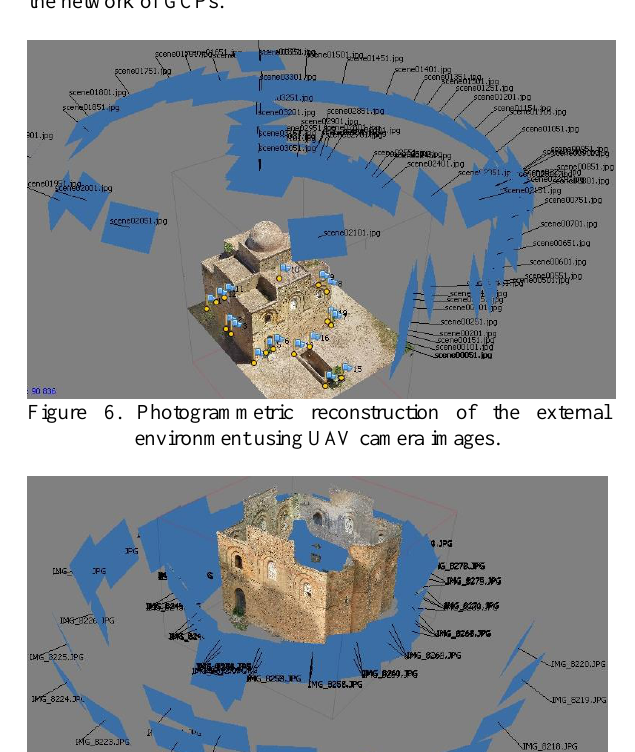
Figure 8. Dense cloud reconstruction of the internal environment using smartphone camera.